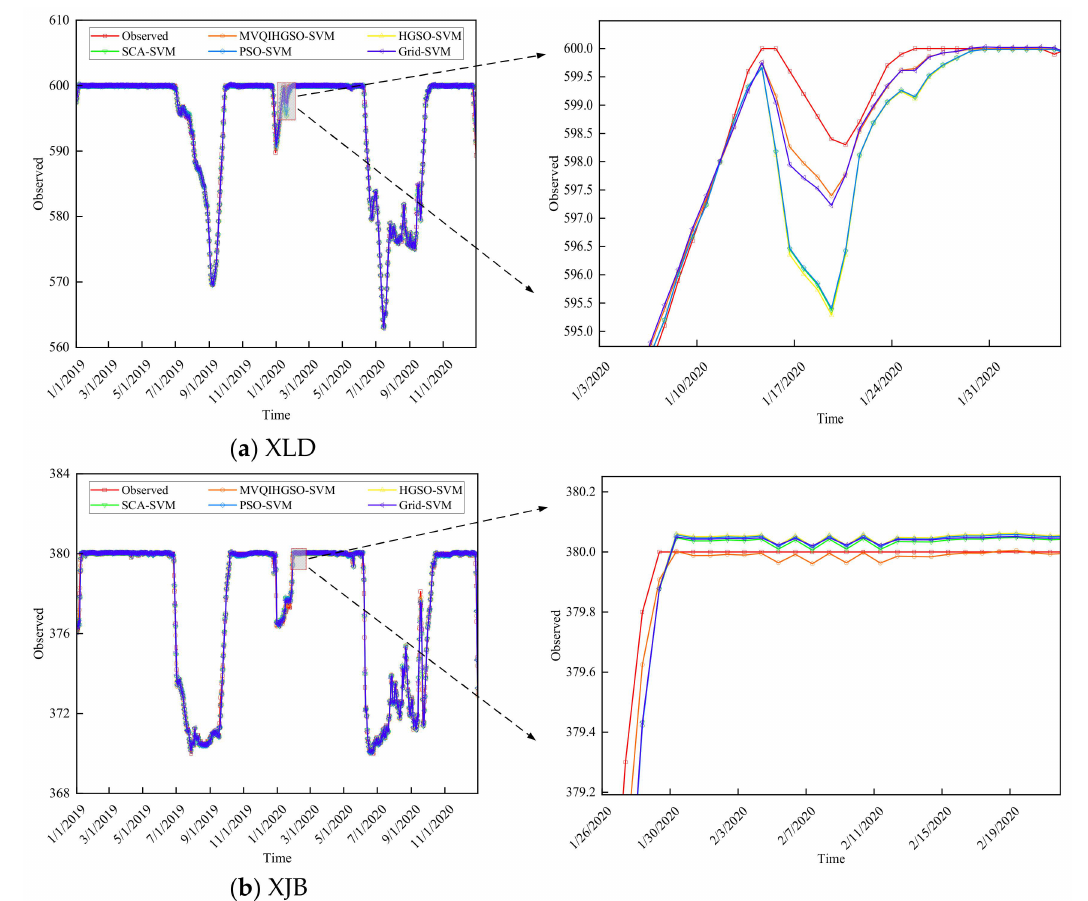
Figure 5. Observed and predicted water level process (unit: m).